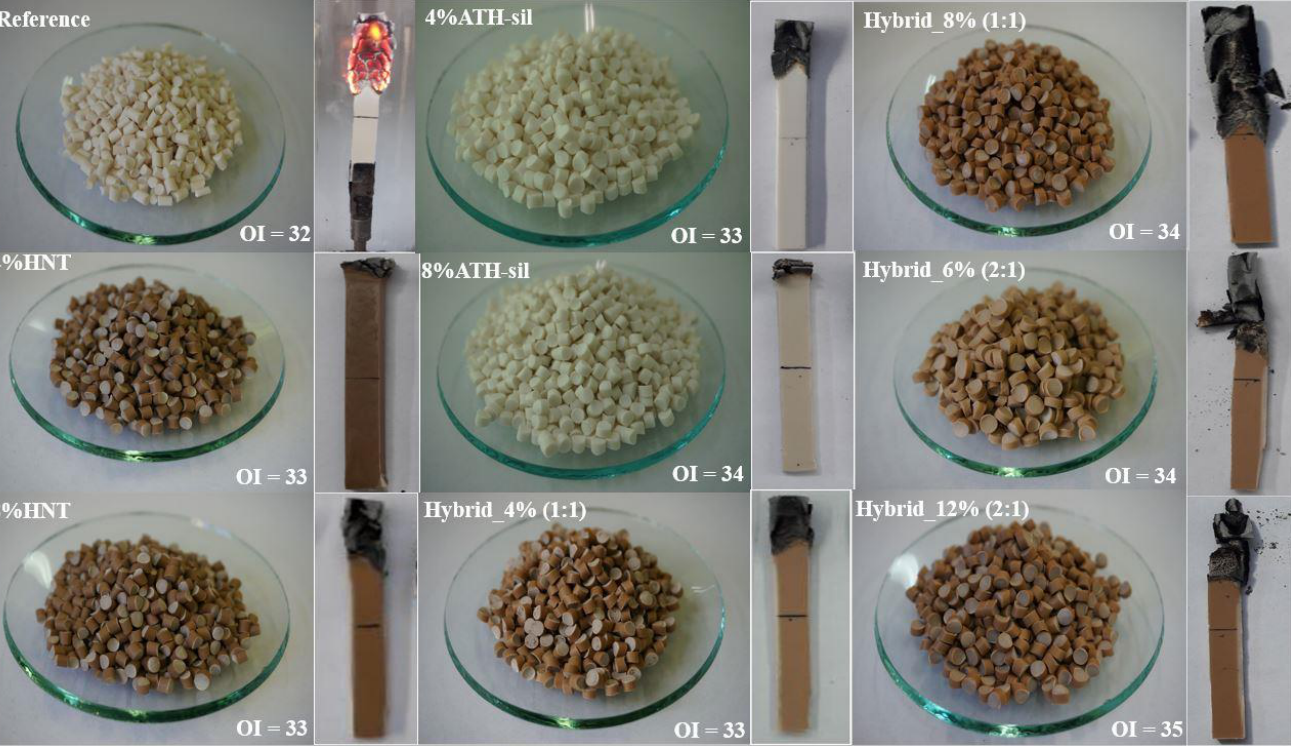
Figure 8. The appearance of the prepared granulates and samples after the flammability test.